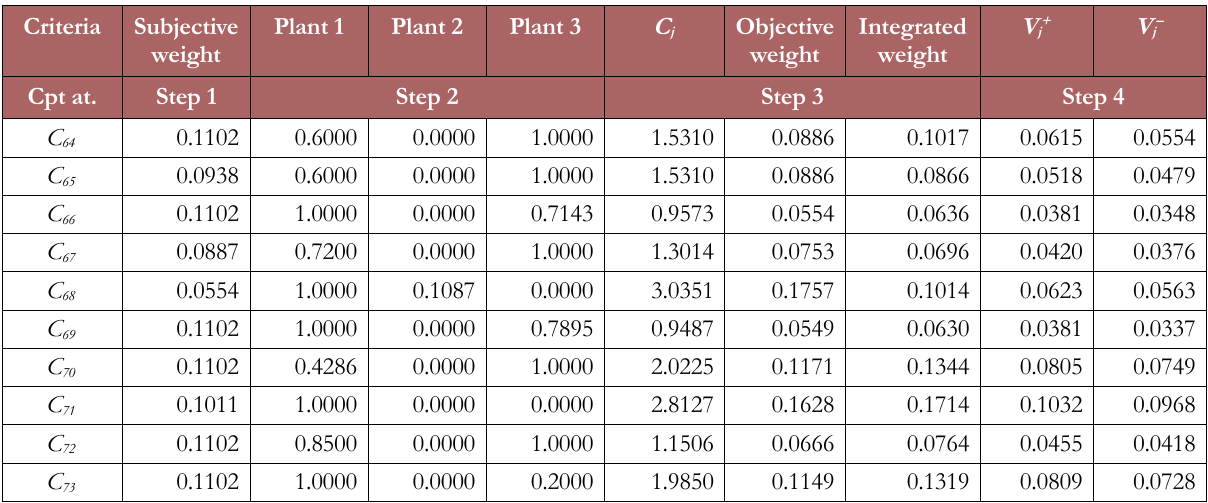
Table 15. Computation of rough BWM-CRITIC-TOPSIS (universal integration)